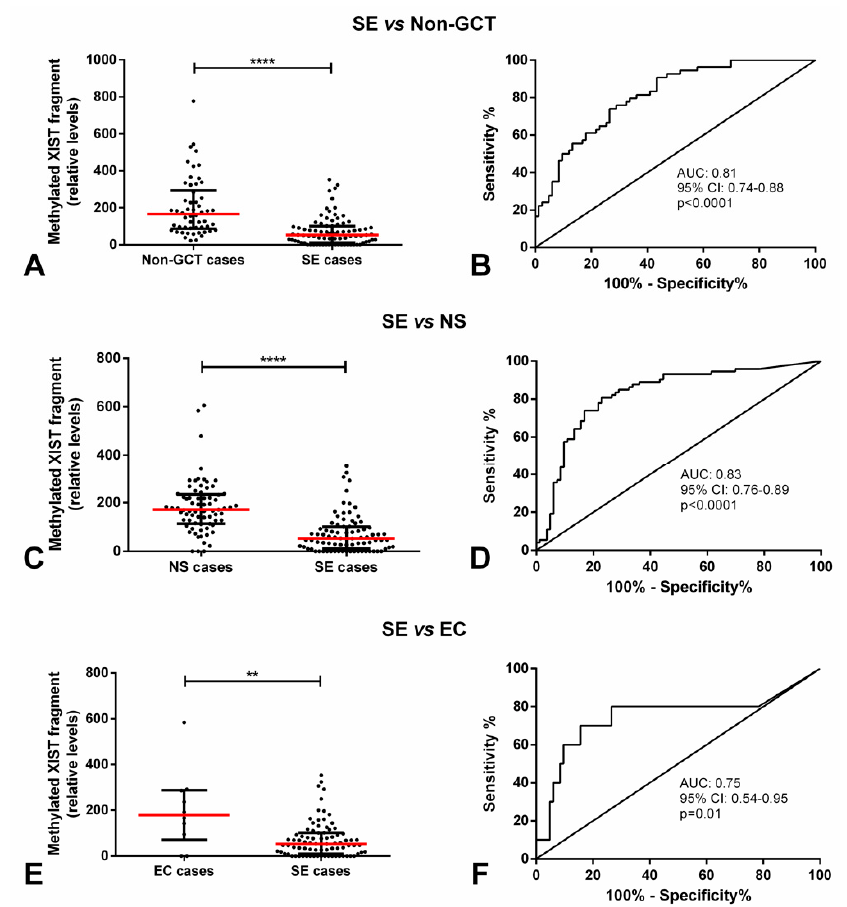
Figure 3. Methylated XIST fragment relative amounts in seminoma patients of the discovery cohort. Relative amounts of the methylated XIST fragment in pure seminoma patients and ( A ) no evidence of TGCT, respective receiving operator characteristic (ROC) curve in ( B ); ( C ) NS, respective ROC curve in ( D ); and ( E ) only pure embryonal carcinoma (EC), respective ROC curve in ( F ). **** indicates p < 0.0001 and ** indicates p < 0.01. Abbreviations: AUC—area under the curve; EC—embryonal carcinoma; GCT—germ cell tumor; NS—non-seminoma; SE—seminoma.